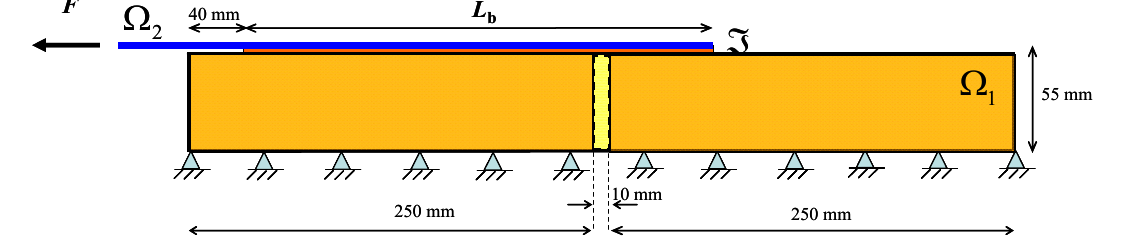
Figure 5: Scheme of the FRP-masonry brick detachment